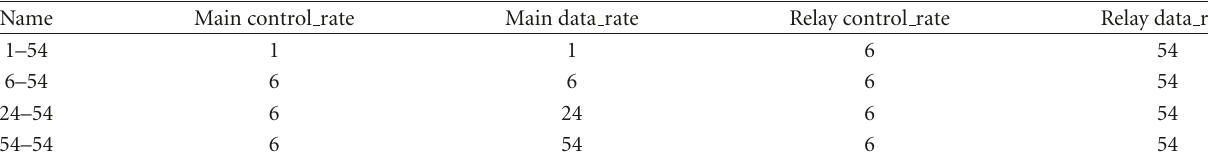
Table 2: Sets of transmission rates (Mbps).